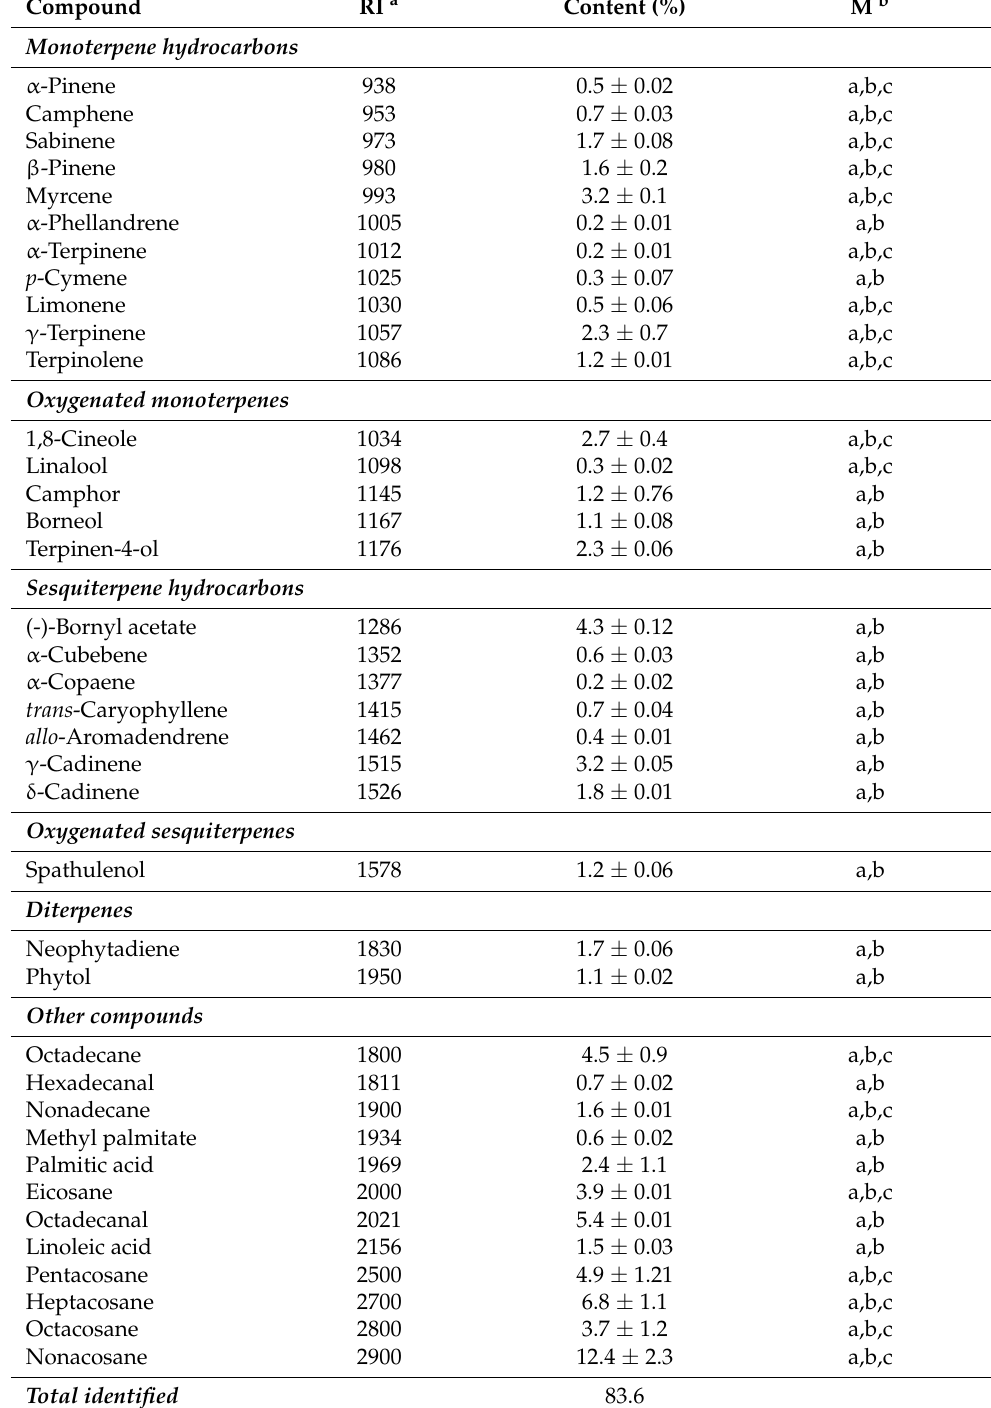
Table 2. The main identified constituents (%) of S. pinnata n -hexane extract (EHSP). Compound RI a Content (%) M b Monoterpene hydrocarbons α